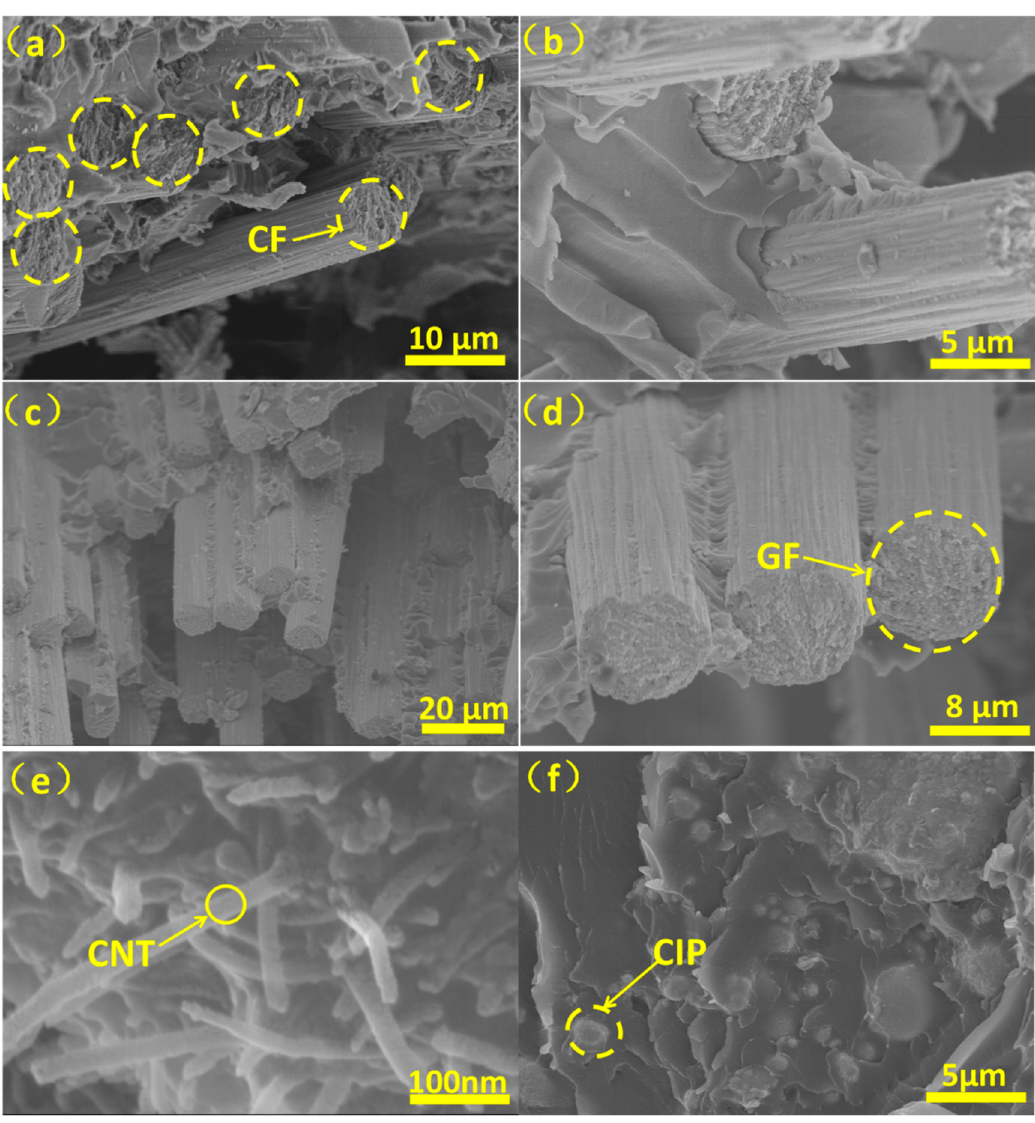
Figure 3. SEM fractures images of SL ( a , b ), WTL ( c , d ) and AL ( e , f ) of the samples with n = 2. According to the Electromagnetic Shielding Material Shielding Effectiveness Measurement Method (GJB 8820-2015), the performance of the samples should be tested in a shielded dark room [25]. The microwave measurement-specific framework for SE evaluation is a window test in free